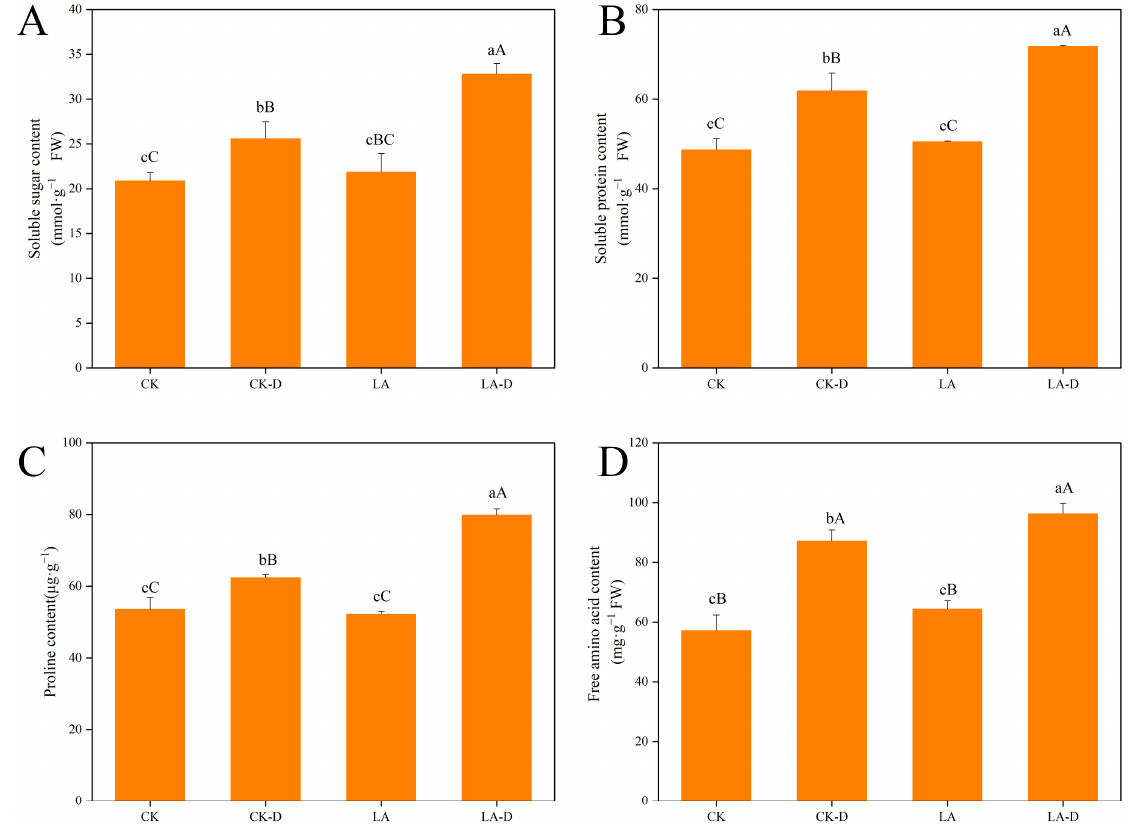
Figure 3. Effects of LA on osmotic regulation substances in P. persica under drought stress. ( A ) Soluble sugar content, ( B ) soluble protein, ( C ) proline content, ( D ) free amino acid content. Values represent means ± SD of three replicates. Different letters indicate significant differences according to Duncan’s multiple range tests.